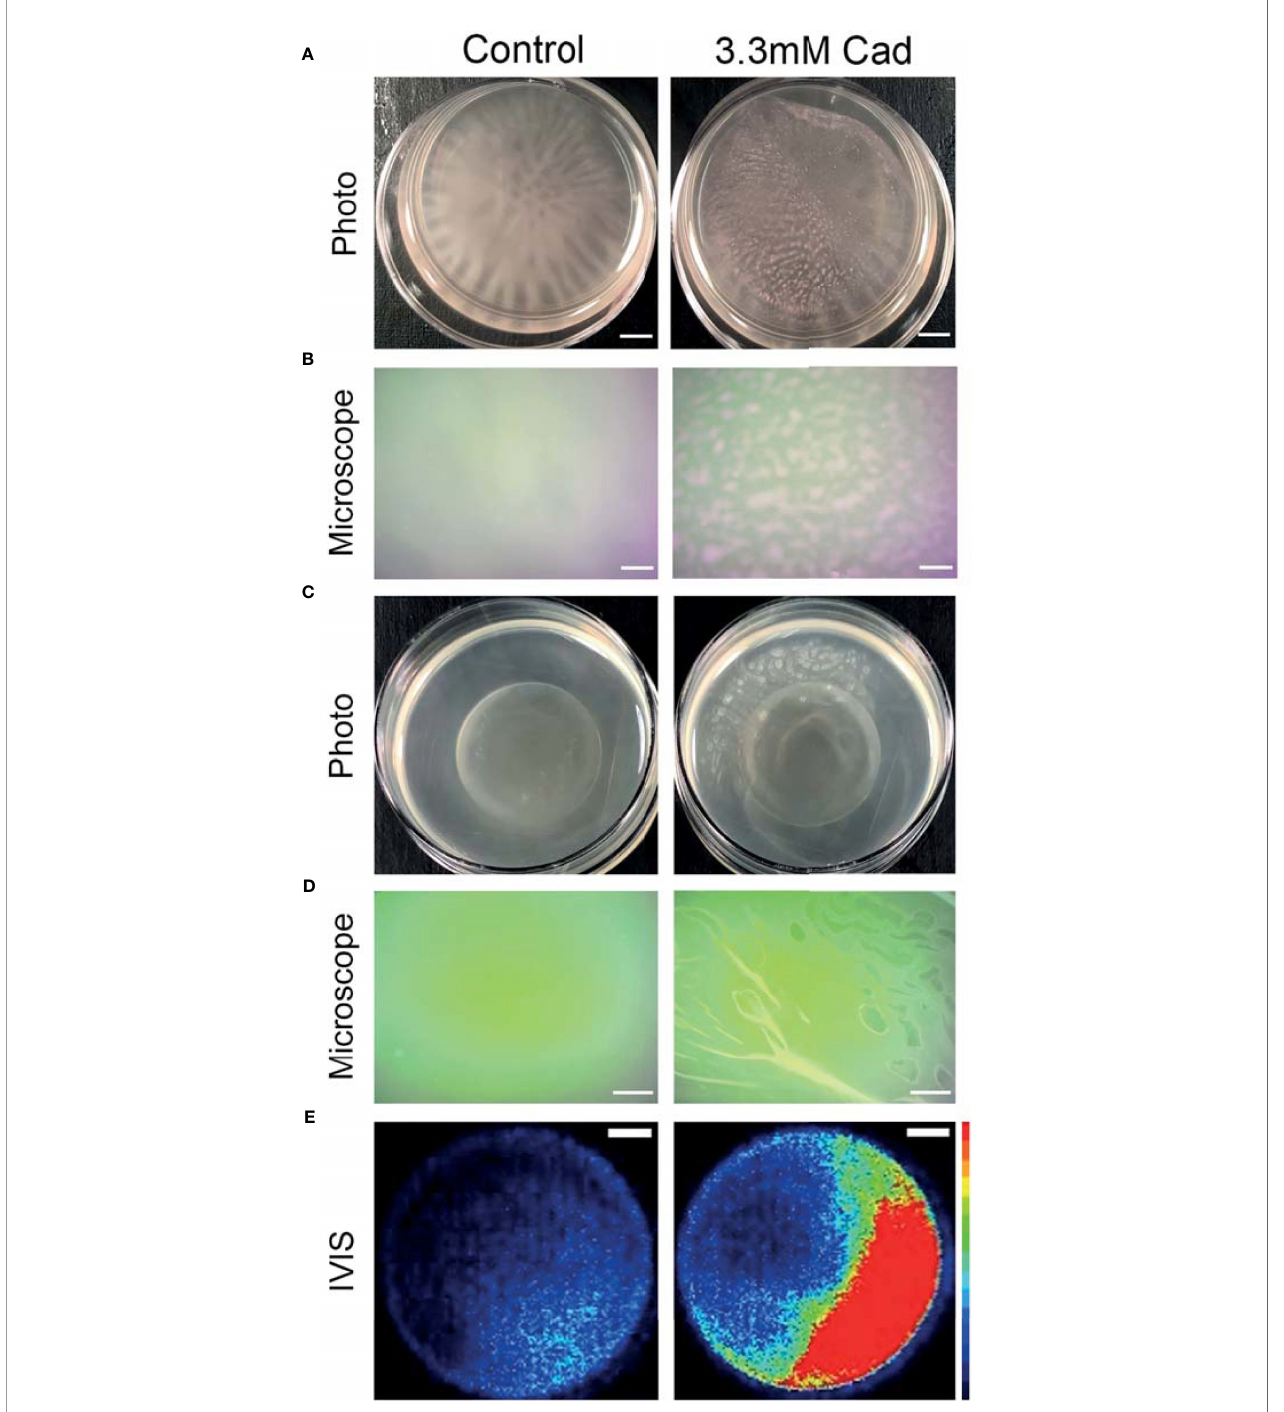
FIGURE 7 | Cadaverine supplementation causes altered bio fi lm morphology to pellicle bio fi lm at the air-liquid interface that is metabolically active. Representative iPhone8 photos (scale bar = 2.9mm) (A) and dissecting microscope images of culture air-liquid interfaces (scale bar = 0.14mm) (B) are taken of PAO1 Td-tomato supplemented with 3.30mM cadaverine (cad) showing pellicle bio fi lm. Representative iPhone8 photos (scale bar = 3.6mm) (C) , dissecting microscope images of culture air-liquid interfaces (scale bar = 0.18mm) (D) , and IVIS images of air-liquid interfaces (scale bar = 3.8mm) with red being the most metabolically active (scale on right of images) (E) are shown of PAO1 Xen41 supplemented with 3.30mM cadaverine. Cadaverine supplementation leads to bio fi lm formation at the air-liquid interface compared to the control, where bio fi lm is localized to the bottom of the